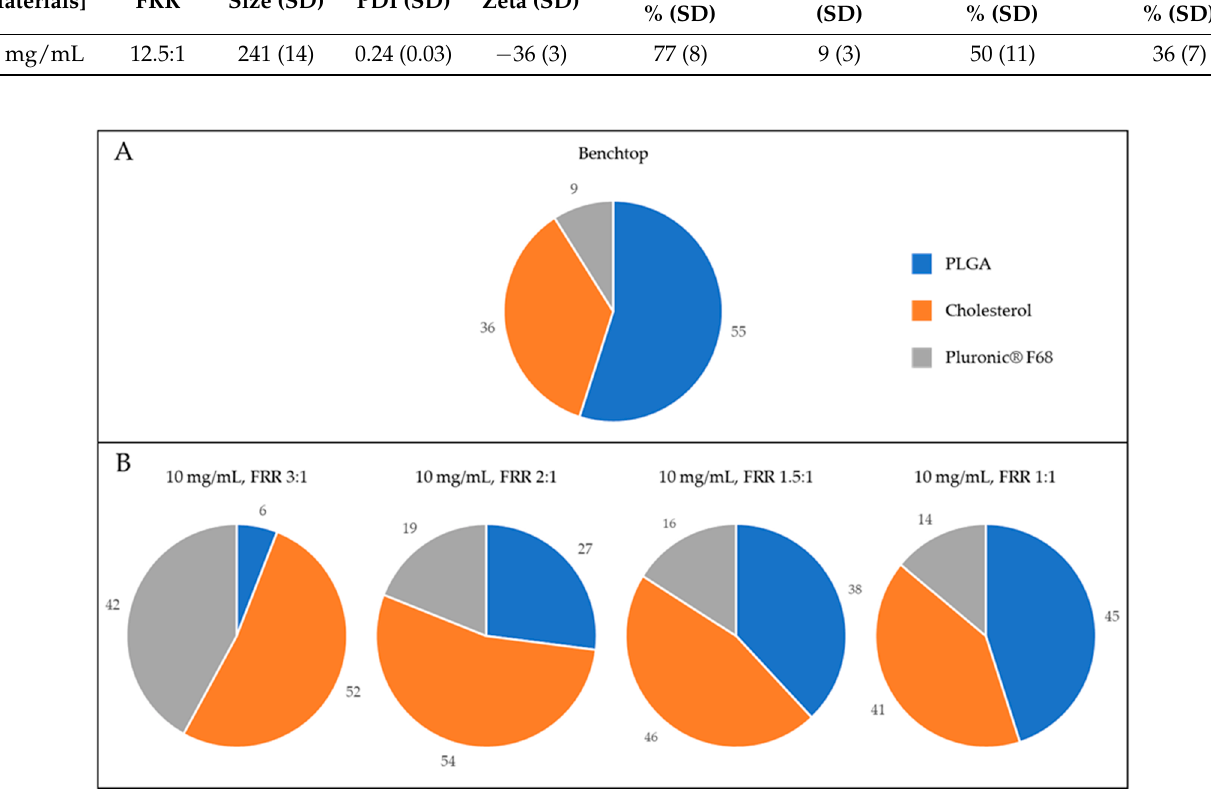
Figure 1. Graphical representation of the composition of H-NMeds. Blue: PLGA content. Orange: Cholesterol content. Grey: Pluronic ® F68 content. ( A ) H-NMeds obtained with nanoprecipitation. ( B ) H-NMeds obtained with microfluidic-based protocols using a concentration of materials in the organic phase of 10 mg/mL and different FRRs, namely, 3:1 (left), 2:1 (center) and 1:1 (right).